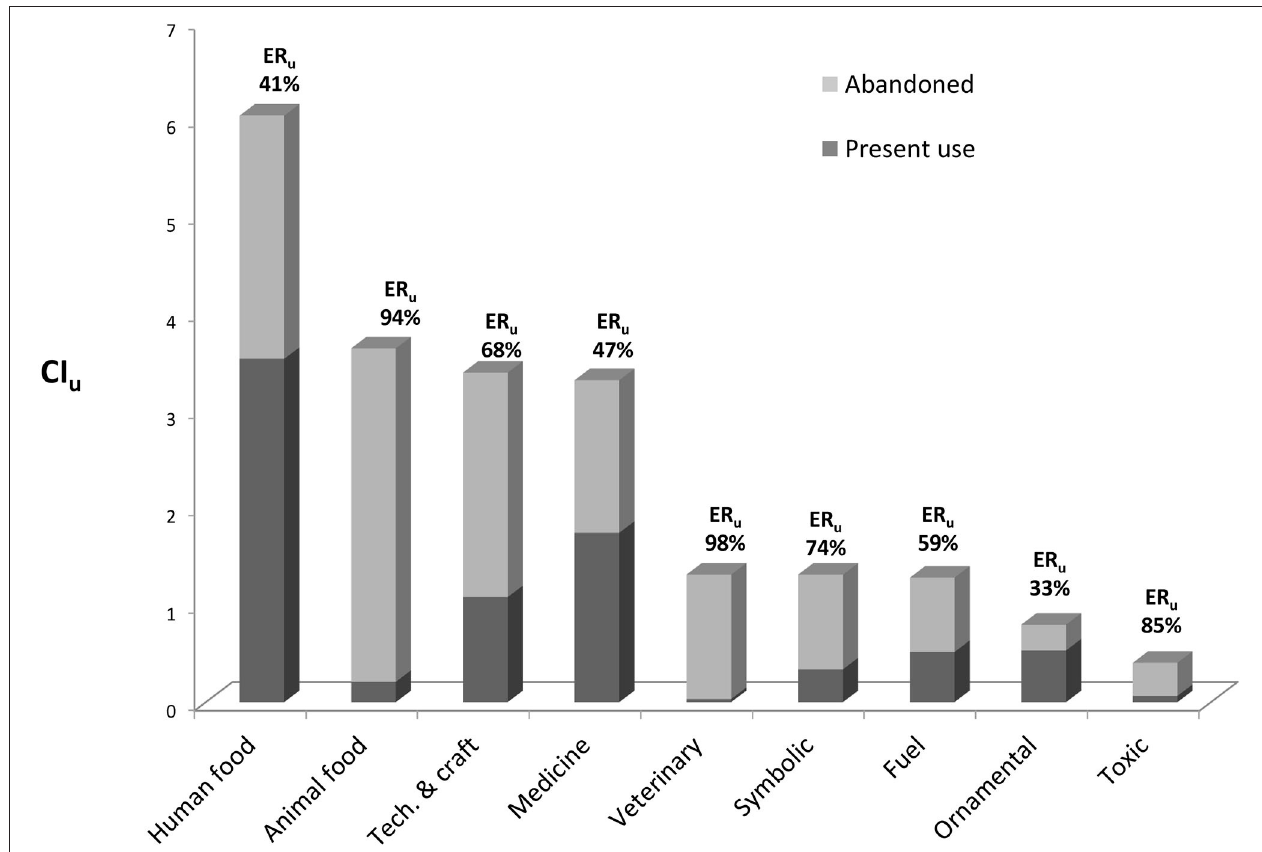
FIGURE 2 | Cultural importance index (CI) of the main